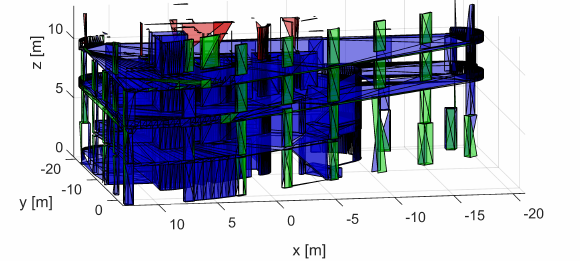
Figure 9. Result of the visibility checks for the point cloud of time step 2 (Figure 6). Green triangles are labeled as potentially built , blue triangles are labeled as unknown and red triangles are labeled as not built .